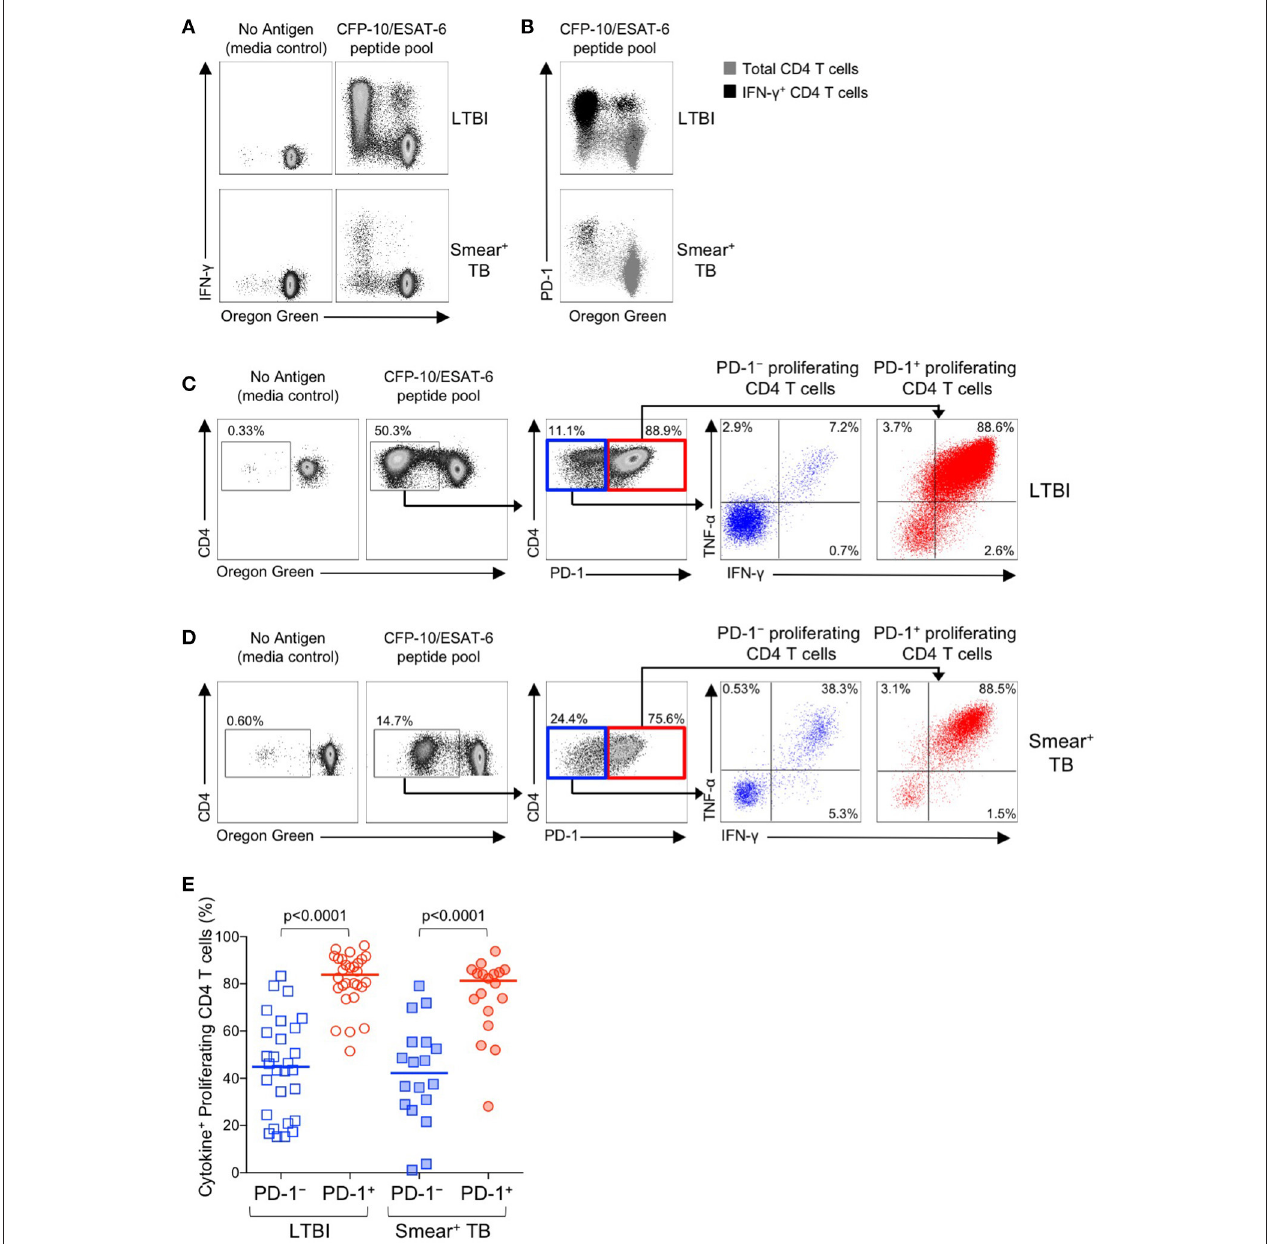
FIGURE 8 | PD-1 + proliferating Mtb-specific CD4T cells exhibit greater antigen-specific cytokine production capacity than PD-1 − proliferating cells. PBMC proliferation assays were performed as described in Figure 6. On day 6 of the assay, cells were re-stimulated with a CFP-10/ESAT-6 peptide pool for 6 h, and then analyzed by flow cytometry for expression of PD-1 and intracellular IFN- γ and TNF- α . (A) Flow cytometry data indicating IFN- γ production capacity by proliferating CD4T cells following incubation of OG-labeled PBMC for 6 days in medium alone, or with a CFP-10/ESAT-6 peptide pool. Cells were re-stimulated with the same peptide pool for 6h on day 6 to measure cytokine production capacity. Plots are shown gated on viable CD3 + CD4 + lymphocytes; data are shown from an individual with LTBI (top row) and a patient with smear + TB (bottom row). (B) Flow cytometry data indicating co-expression of PD-1 and IFN- γ by OG lo CD4T cells following stimulation with a CFP-10/ESAT-6 peptide pool. Plots are shown gated on viable CD3 + CD4 + lymphocytes; data are shown from an individual with LTBI (top row) and a patient with smear + TB (bottom row). Gray cells indicate total CD4T cells; black cells indicate IFN- γ + CD4T cells. (C,D) Flow cytometry data indicating the gating strategy for analysis of cytokine production capacity by PD-1 − and PD-1 + proliferating CFP-10/ESAT-6-specific CD4T cells. Cells were first gated on viable CD3 + CD4 + lymphocytes, then on proliferating (OG lo ) CD4T cells, which were then gated on PD-1 − and PD-1 + cells, and further analyzed for intracellular IFN- γ and TNF- α production. Data shown in (C) are from an individual with LTBI; data shown in (D) are from a patient with smear + TB. (E) Proportion of CFP-10/ESAT-6-specific PD-1 − and PD-1 + proliferating CD4T cells that produce IFN- γ and/or TNF- α following re-stimulation with CFP-10/ESAT-6 peptide pools for the final 6h of the 6-day proliferation assay. Only individuals with CFP-10/ESAT-6-specific CD4T cell proliferation above background were included in this analysis ( n = 28 LTBI; n = 18 smear + TB). Horizontal lines represent the median. Differences between cytokine production capacity of PD-1 − and PD-1 + proliferating CD4T cells was determined using the Wilcoxon matched pairs signed rank